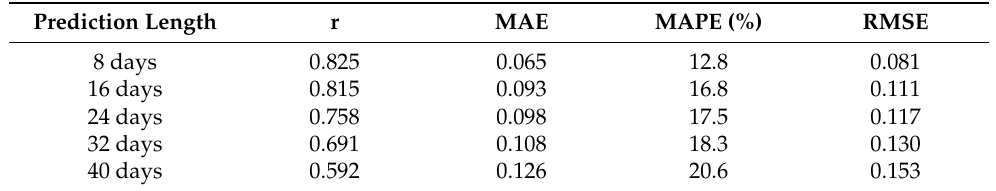
Table 2. r, MAE, MAPE and RMSE of predictions using the DTW–LSTM method for different prediction horizons.